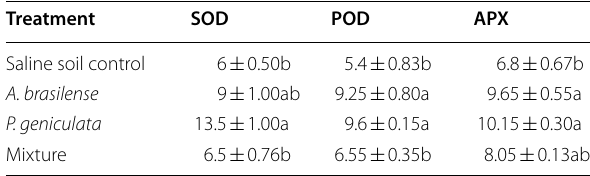
3) standard error. = ±